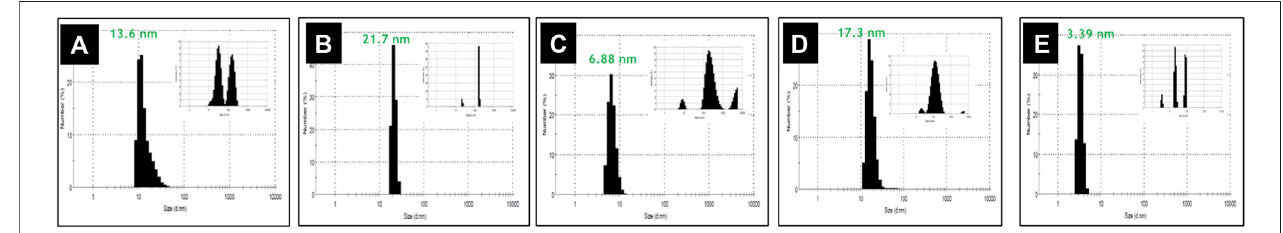
FIGURE 12 | DLS result of α -synuclein control samples and samples treated with volatile compounds Cin, PEA, and TEMED after 72 h of incubation. (A) Not- heated α -synuclein; (B) not-treated α -synuclein; (C) α -synuclein treated withPEA; (D) α -synuclein treatedwith TEMED; (E) α -synucleintreatedwithCin.The DLSresults in the intensity mode for each sample are given as inset to panels (A – E)